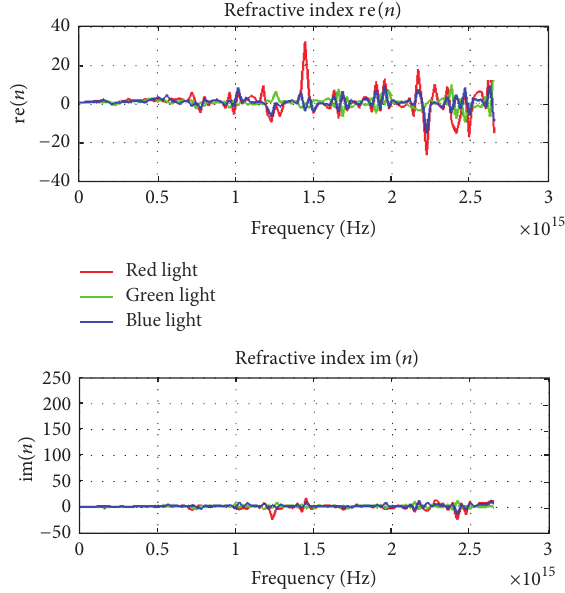
Figure 18: Refractive index (real and imaginary) versus frequency for red, green, and blue light corresponding to conditions in Table